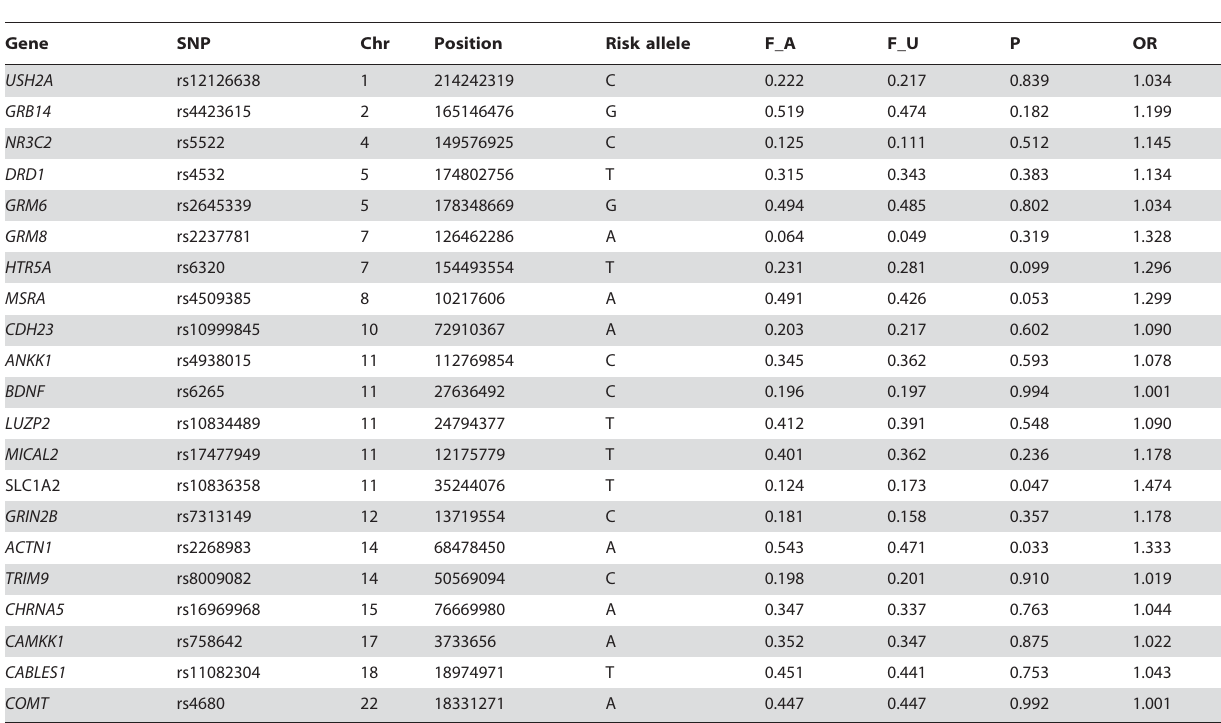
Table 2. Genetic association data for 21 candidate SNPs for smoking behavior.